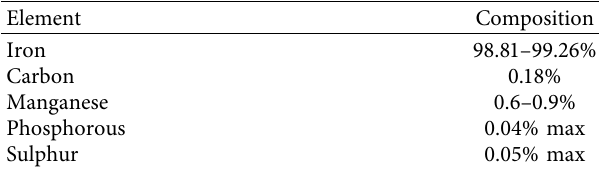
Figure 1: Cylindrical shaped mild steel materials. Table 1: Chemical composition of mild steel.